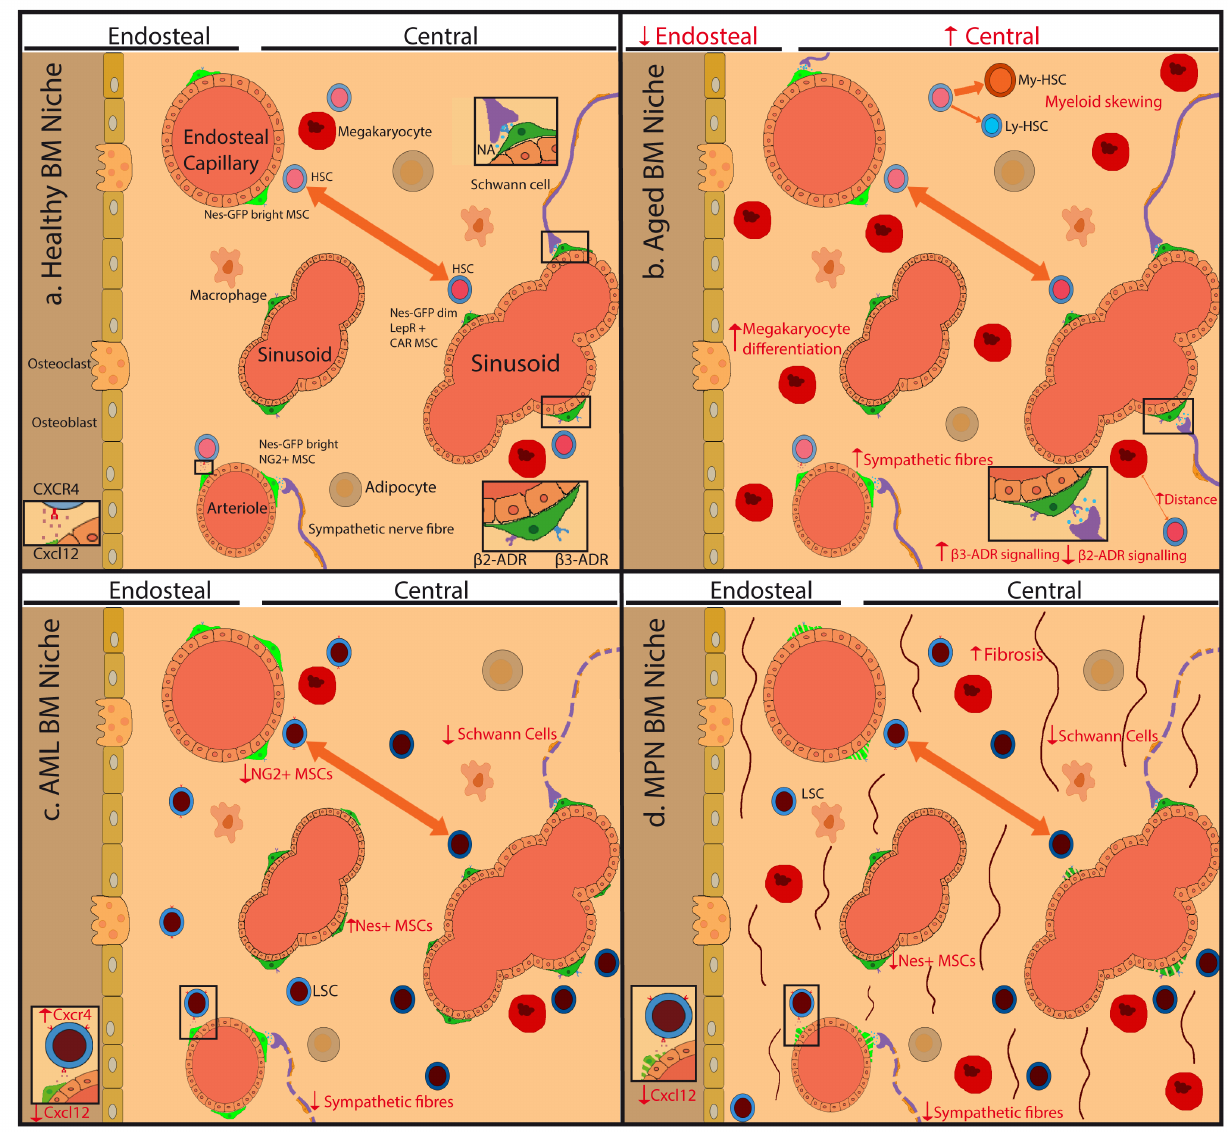
Figure 1. Model illustrating hematopoietic stem cell niche alterations with aging and age-related myeloid malignancies. Scheme shows key hematopoietic stem cell (HSC) niche cell types and their alterations during aging and age-related myeloid malignancies. ( a ) Mesenchymal stem cells (MSCs), which can differentiate into osteoblasts or adipocytes, regulate HSCs in endosteal niches enriched in transition zone capillaries or in central niches enriched in sinusoids. Nestin-green fluorescent protein (Nes-GFP) bright neural-glial antigen 2 (NG2) + MSCs are associated with endosteal capillaries and arterioles located throughout the bone marrow (BM), whereas Nes-GFP dim leptin receptor (LEPR) + CXC-chemokine ligand 12 (CXCL12)-abundant reticular (CAR) MSCs are associated with sinusoids in the central BM. Sympathetic nerve fibers regulate CXCL12 expression in MSCs and the migration of HSCs through the sinusoids. Different MSC subpopulations, endothelial cells, non-myelinating Schwann cells, and megakaryocytes contribute to regulate HSC proliferation. ( b ) During mouse aging, sympathetic fibers increase, but β -adrenergic signaling is reduced, whilst β -adrenergic signaling increases promoting myeloid skewing. Megakaryocytes 3 2 increase but locate further away from HSCs. ( c , d ) In myeloid malignancies, a damage to this neural regulation of MSCs might contribute to disease progression. (c) In acute myeloid leukemia (AML), sympathetic nerve fibers and NG2 + Nes-GFP bright MSCs decrease, whilst Nes-GFP dim MSCs increase, although the implications for human AML are unknown. (d) In MPN, the neuroglial damage leads to apoptosis of Nestin-GFP + MSCs, which can be rescued through chronic treatment with sympathicomimetic drugs that indirectly improve reticulin fibrosis in mice and humans. ADR, adrenergic receptor, NA,